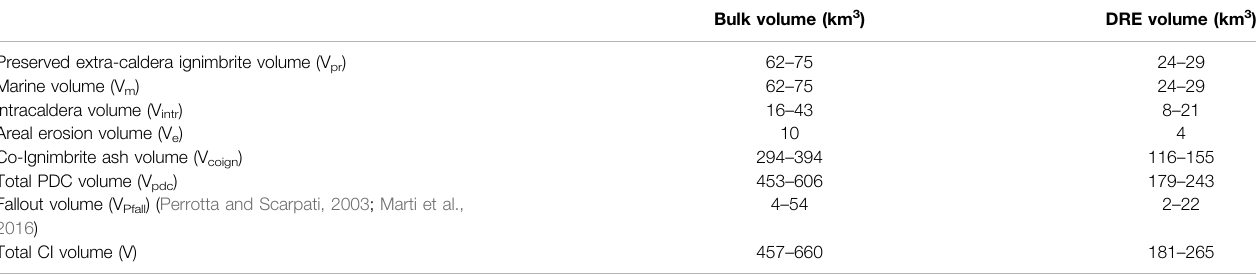
TABLE 3 | The volume of the CI eruption. The various parts of the PDC volume estimate are explained in the text. The fallout volume considered in this work is the maximum and the minimum proposed in literature by Perrotta and Scarpati (2003) and Marti et al. (2016).